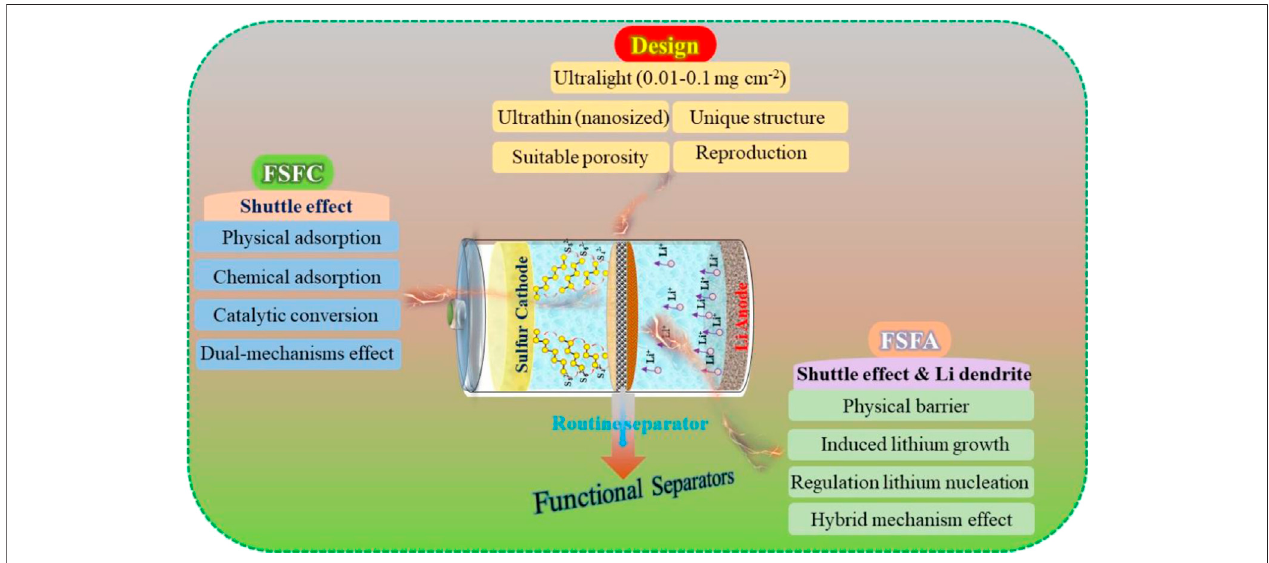
FIGURE 1 | Schematic diagram of functional separators and their design based on the various working mechanisms for LSBs.